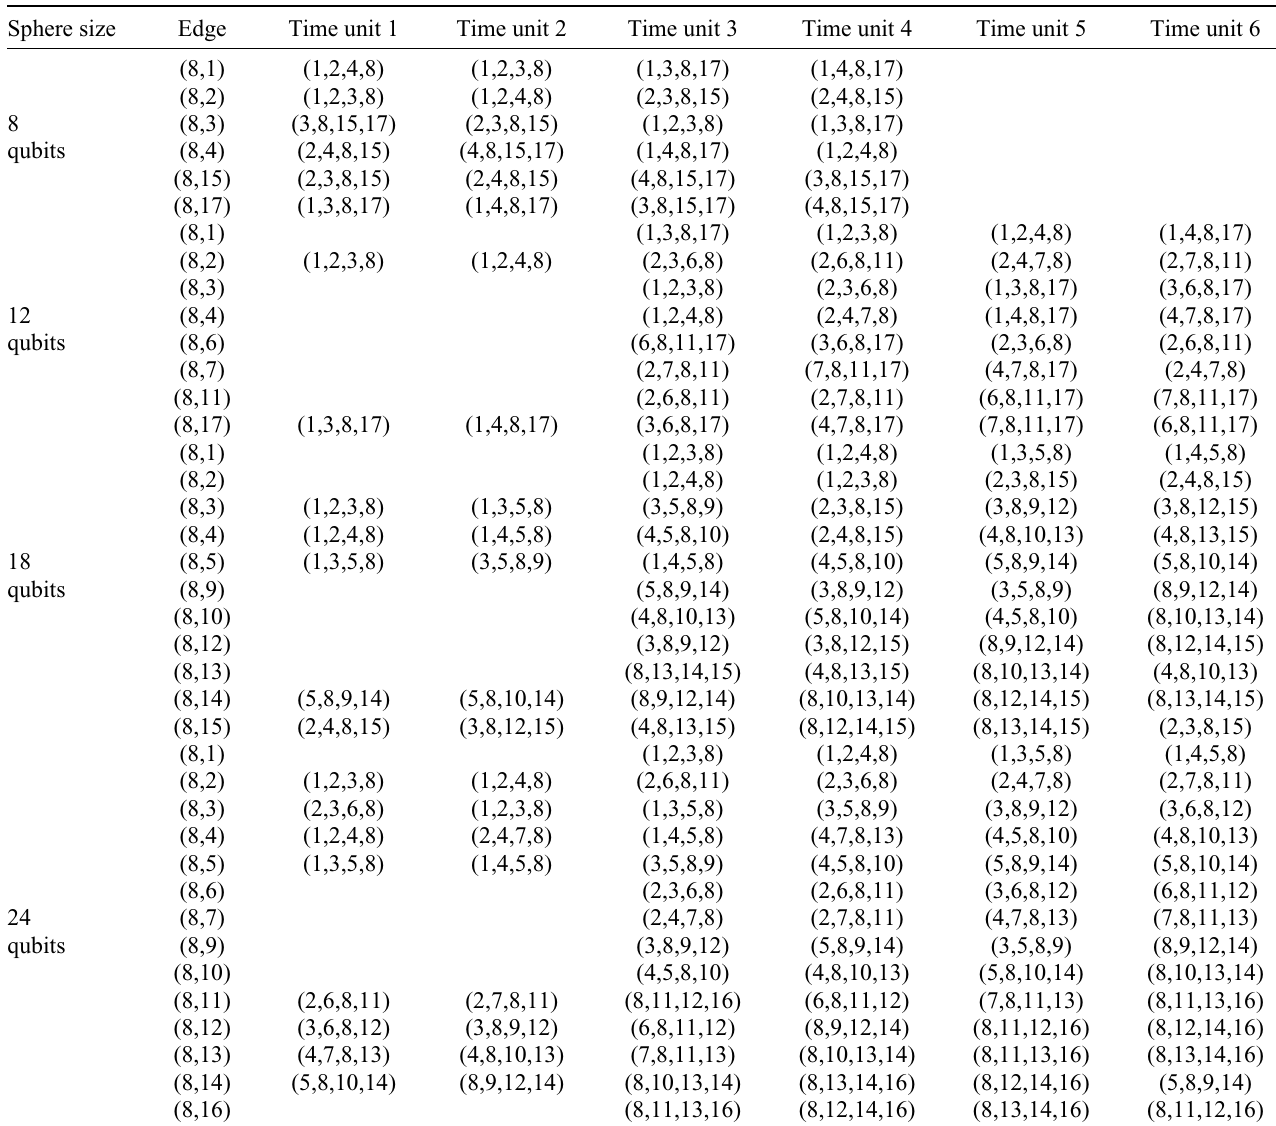
TABLE V. Shortest CNOT sequences to measure each Z stabilizer with a single ancilla for the 8-, 12-, 18-, and 24-qubit spherical color codes in Fig. 38. Sets of two and four vertices from v list are used to label edges (measurement qubits) and tetrahedra (data qubits), which form the target and control of each CNOT , which is applied in the specified time unit. Note that weight-4 stabilizers have their CNOT s applied in the last 4 time units, avoiding unnecessary idle times in the measurement